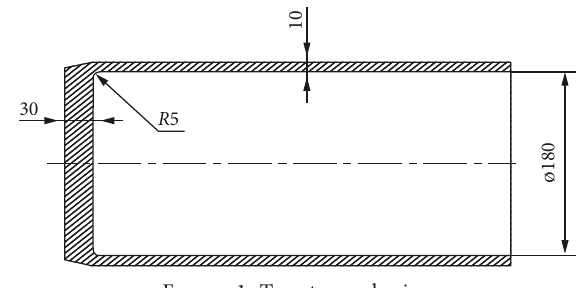
Figure 1: Target sample size.